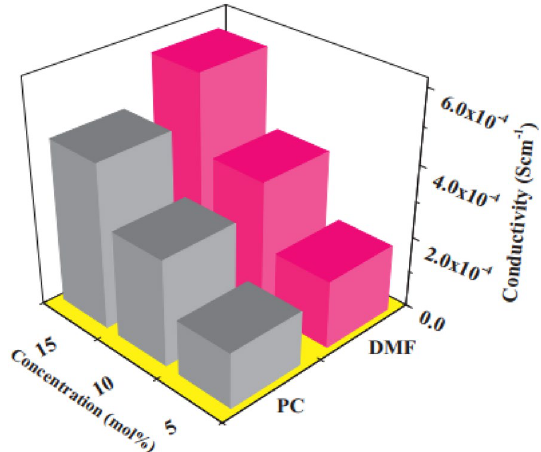
Fig. 7 Influence of plasticizers chemistry and concentration on the conductivity of PECH electrolytes (PC and DMF plasticizers)